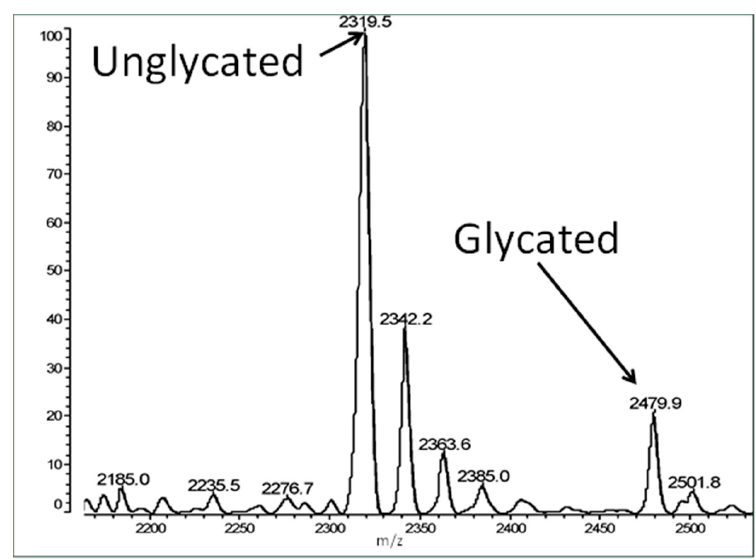
Figure 3. Matrix assisted laser desorption/ionization-time of flight (MALDI-TOF) spectrum illustrating non-enzymatic glycation of insulin receptor peptide 897–916 glycated in 20 mM glucose for 6 days. The unglycated peptide peak is at 2319.5 amu. Peptides were desalted with 0.1% TFA prior to analysis but some salt remained. Thus multiple peaks are observed immediately adjacent to the most prominent peak at intervals of 11 amu, which represent ionized sodium adducts produced by the desorption/ionization event in MALDI. An additional peak is observed at 160 amu (the mass of the glucose adduct) from the unglycated peptide peak, which represents the glycated peptide.